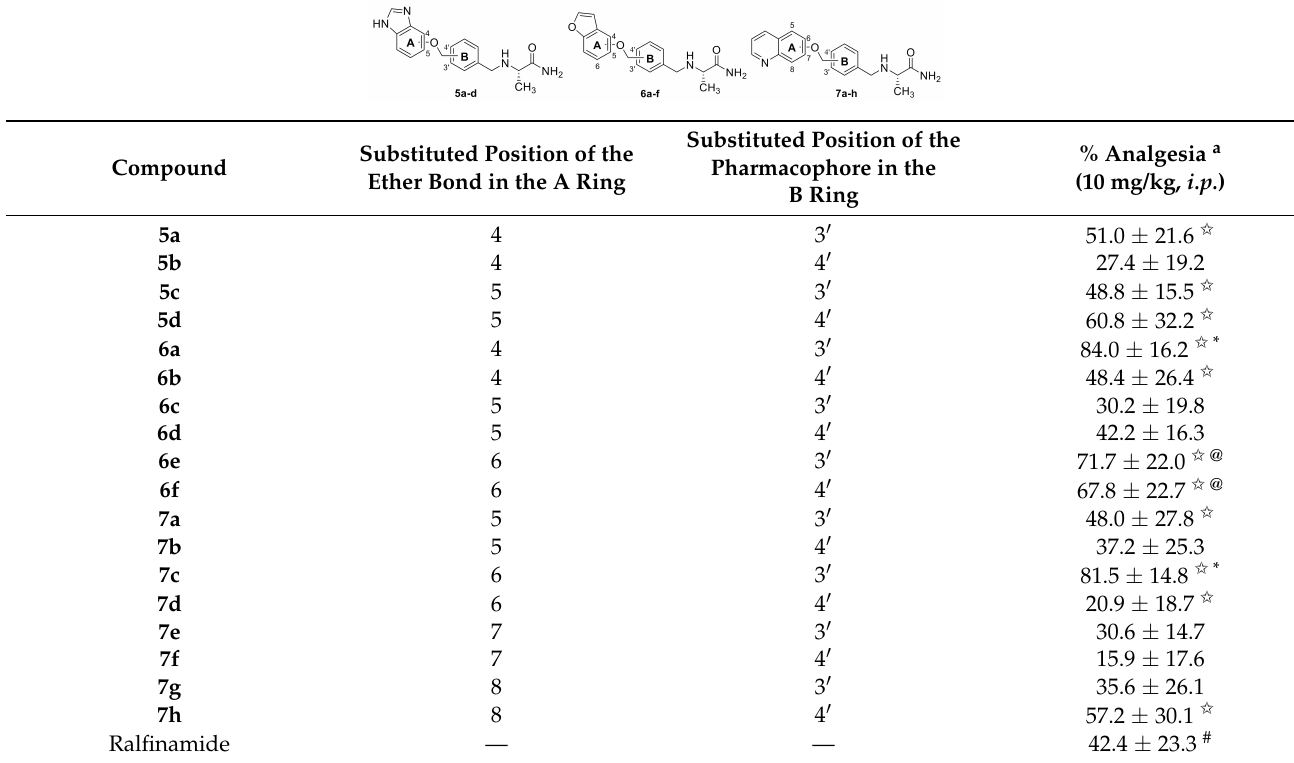
Table 1. The analgesic activity of the synthesized compounds in the formalin test.